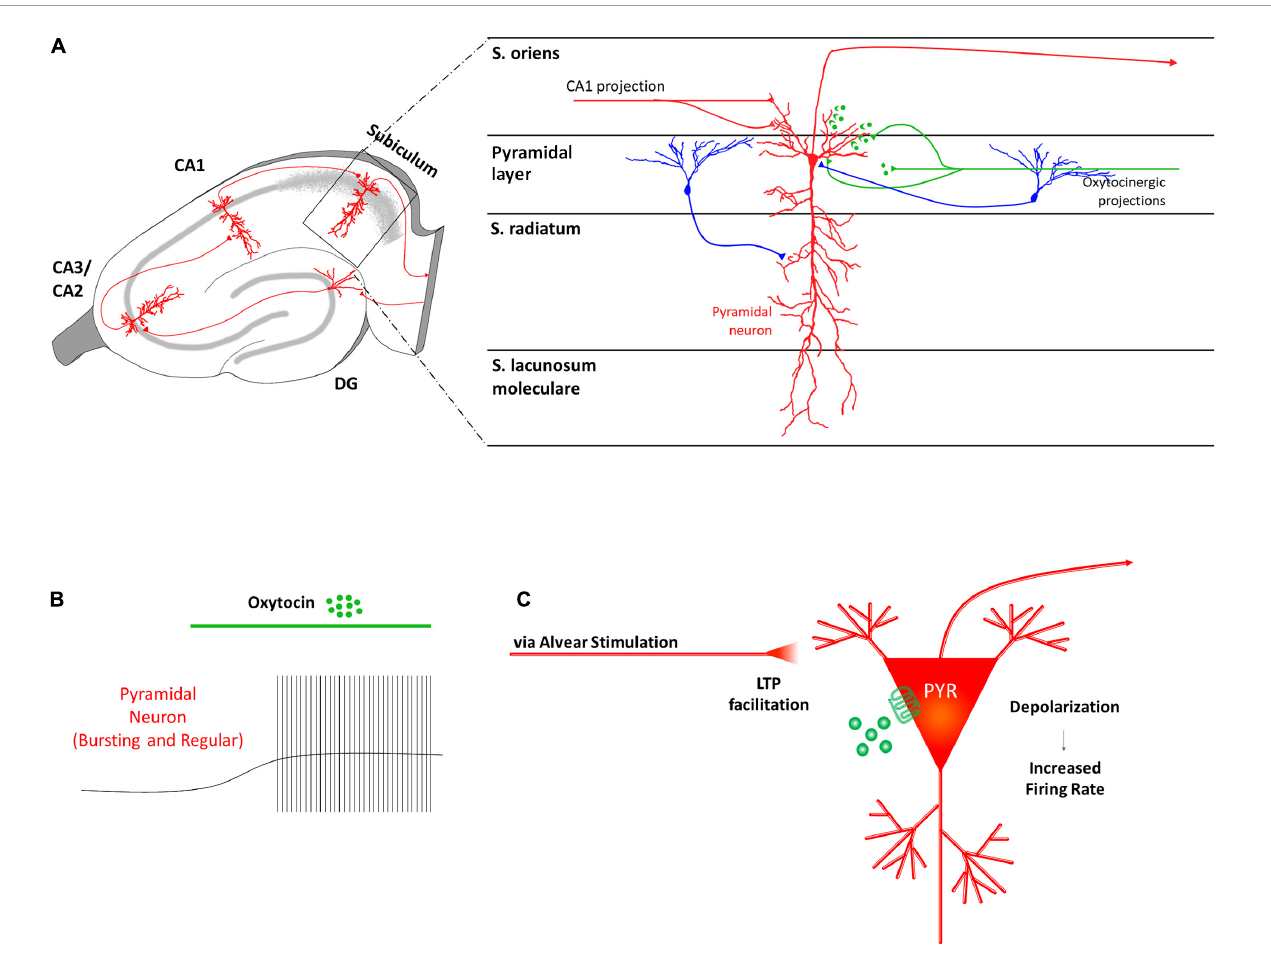
FIGURE4 Receptor distribution, oxytocinergic projections and main effects exerted by oxytocin (OT) at subiculum region of the rodent’s hippocampus. (A) In the subiculum, OTRs are known to be expressed by glutamatergic pyramidal neurons (PYR–red) that receive oxytocinergic afferent fibers (green). (B) OT causes a significant depolarization of the membrane potential and increases the firing rate of the subicular PYRs. (C) The OT-dependent increased excitability of the PYRs in the subiculum is thought to be crucial in transmitting information exiting the